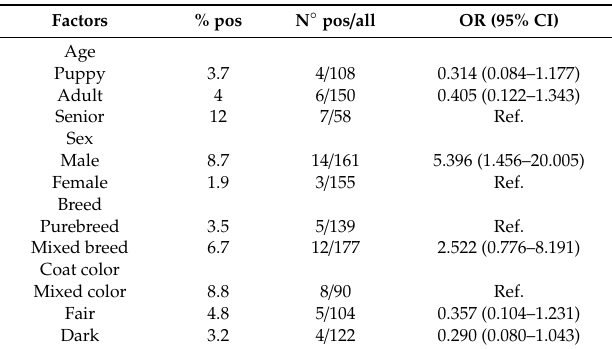
Table 2. Borrelia seropositivity according to characteristics of dogs: percentage of positive, number of positive, odds ratio related 95% confidence intervals (95% CI); Reference